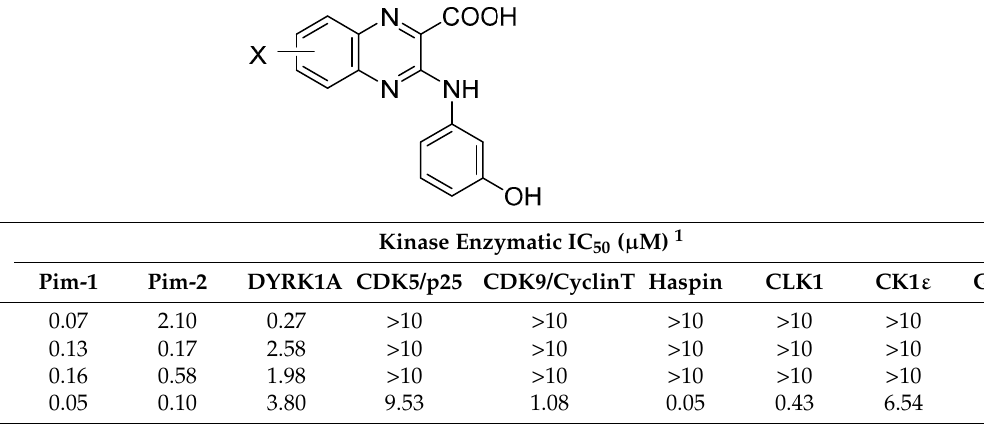
Molecules 2021 , 26 , x FOR PEER Table 2. Kinase selectivity profile of the most active quinoxalines (ADP-Glo method at 10 µ M ATP).